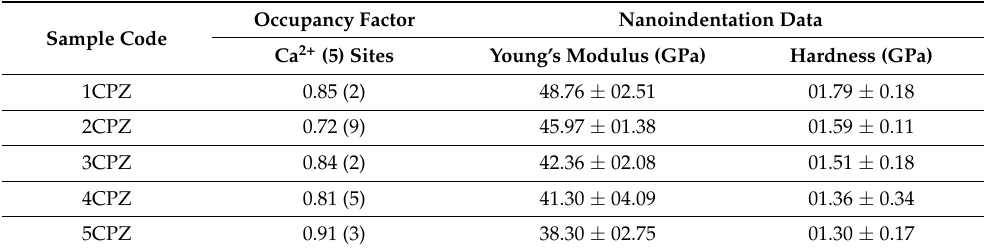
Table 4. Refined occupancy factor of Zr 4+ for Ca 2+ accommodation in the composites. Young’s modulus and hardness data were acquired from the β -Ca 3 (PO 4 ) 2 –ZrO 2 composites at 1100 ◦